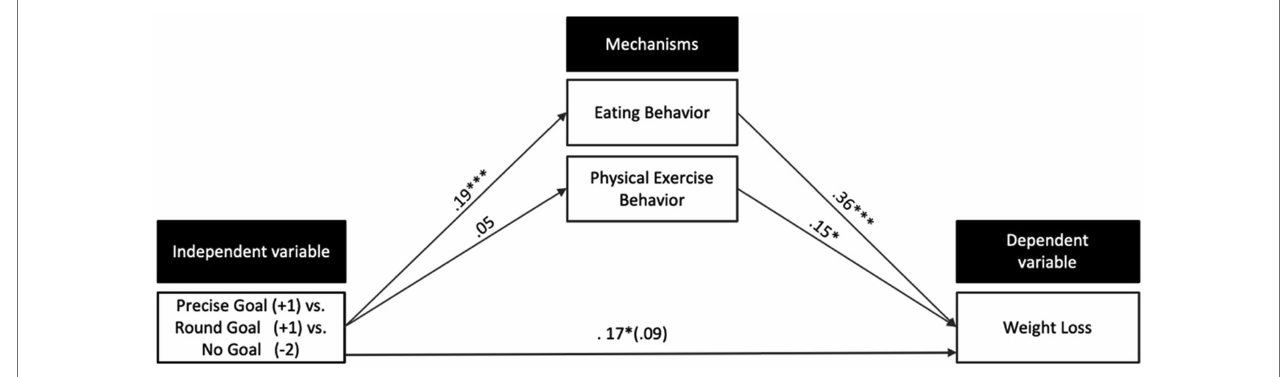
FIGURE 4 | Multiple mediation model with IPD data across both experiments. The model shows that the effect of goals on weight loss was mediated via participants’ eating behavior during the weight loss phase. The indirect effect via physical exercise was non-significant. Path coefficients are standardized regression weights with values of p . * p < 0.05; *** p <